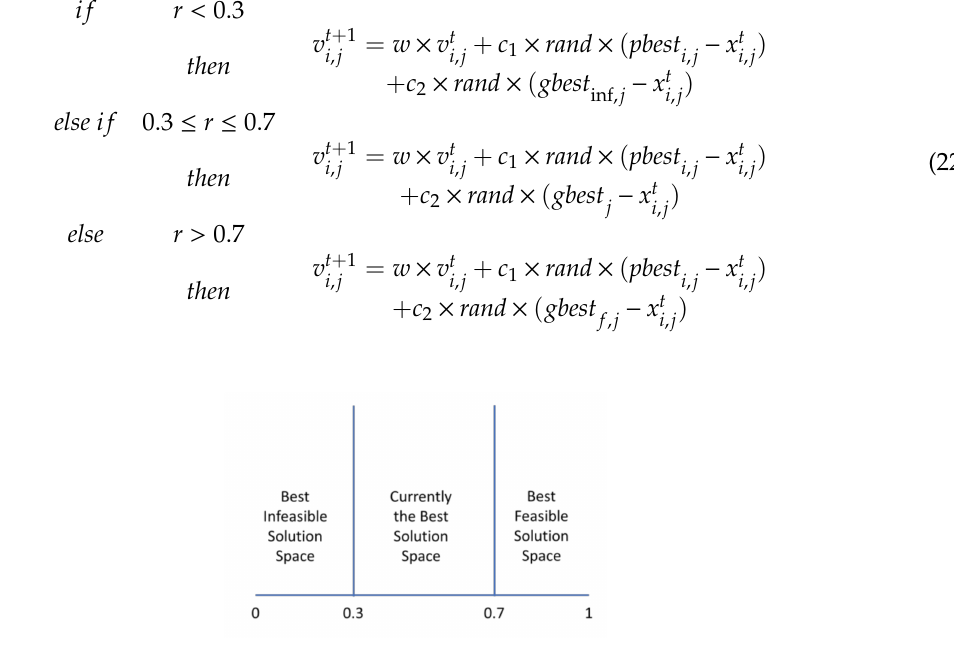
Figure 5. The auto-adjust scheme of